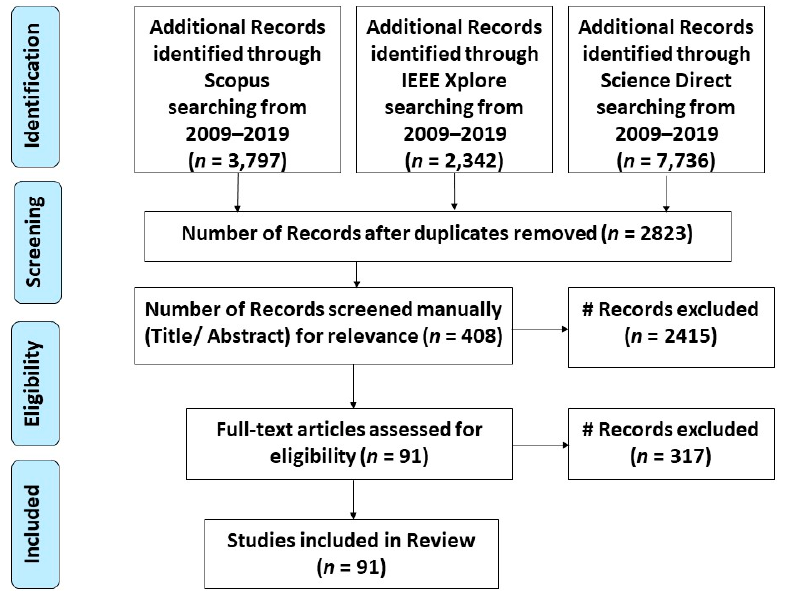
Figure 2. PRISMA flow diagram for the literature review [15].